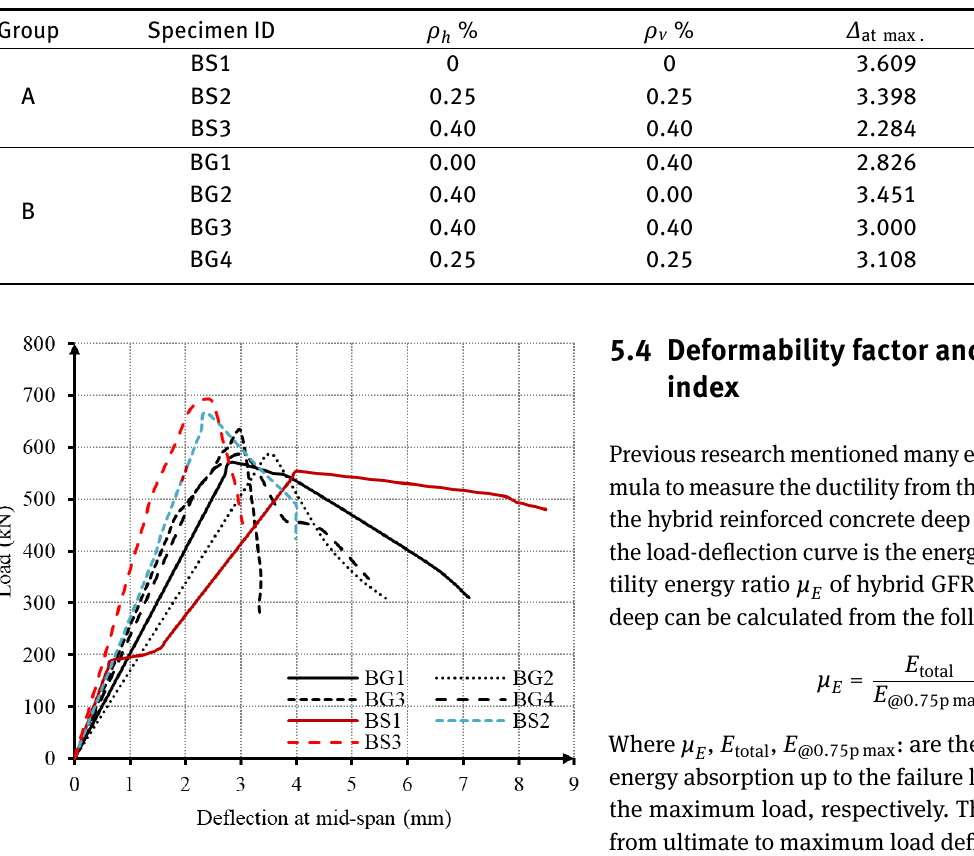
ment was 3.60 mm, while it was 2.39, 2.28 mm for the deep beam with steel web reinforcement ratio of 0.25, 0.40%; respectively, with the difference of 50% about the deflec- tion for control deep beam without web reinforcement as shown in Figure 6. By increasing the steel web reinforce- ment ratio by 0.15%, the mid-span deflection was reduced by 17%. The deflection for deep beam reinforced with verti- cal, horizontal GFRP web reinforcement only decreased by 33, 10%; respectively, and 45, 50% for GFRP web reinforce- ment ratio 0.25, 0.40%; respectively, compared with control deep beam. With the increase of GFRP web reinforcement ratio of 0.15%, the total deflection at mid-span decreases by 21.5%, at maximum load. The increasing deflection for the deep beam with GFRP web reinforcement 0.25, 0.40% about 48, 58%; respectively, compared with the same deep beam reinforced with steel web reinforcement at the same ratio and load. All specimens exhibited a nearly bilinear up to failure.